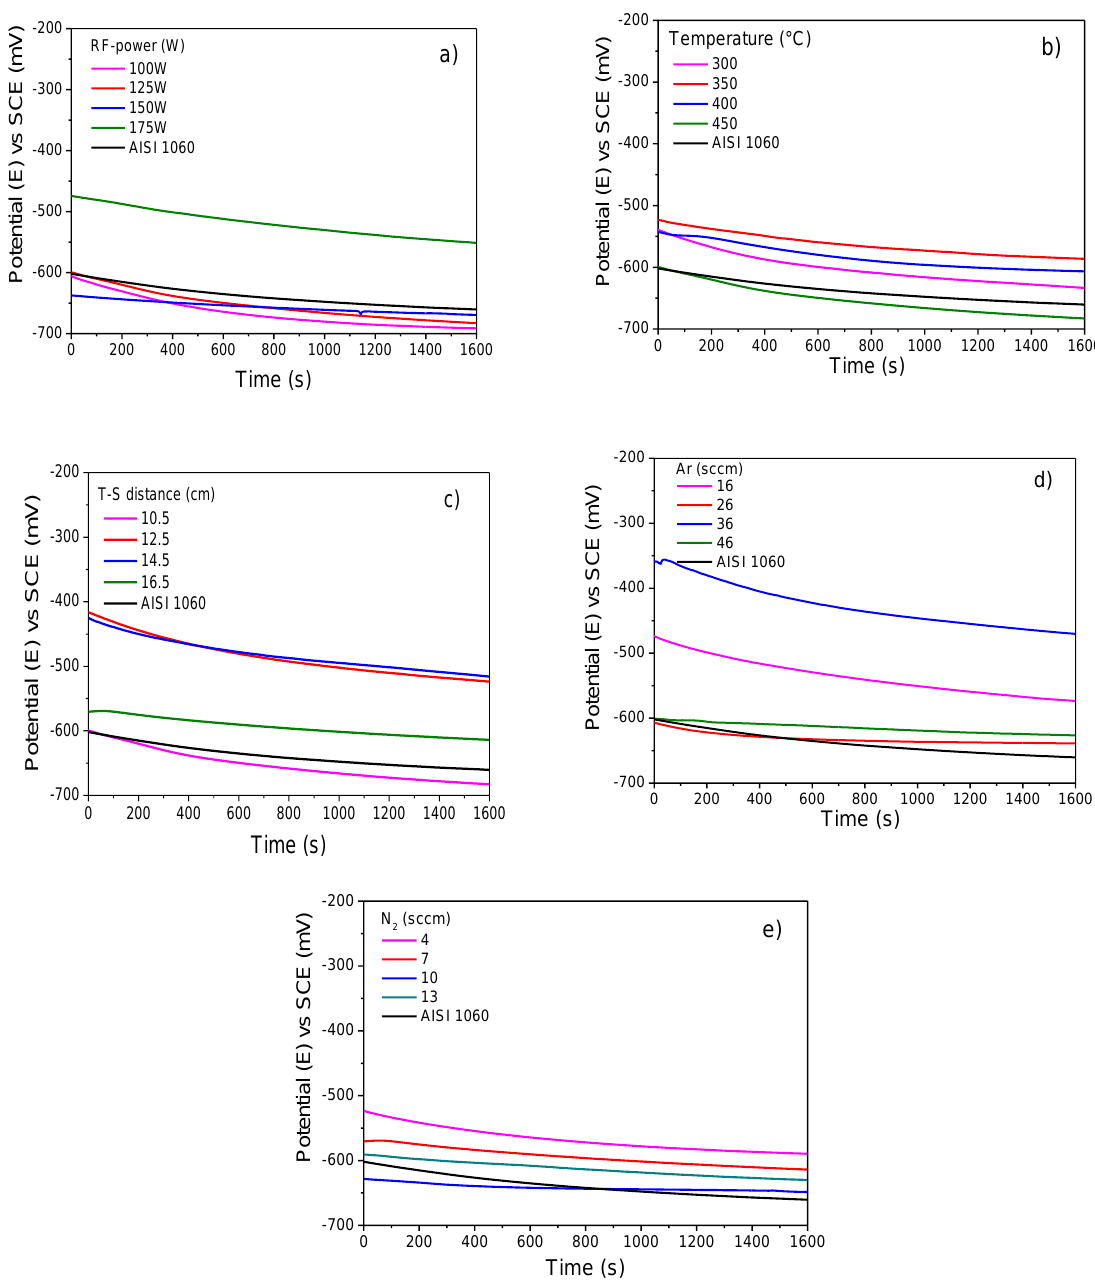
Figure 3. Open circuit potential of Ti/TiN films in neutral 3.5 wt% NaCl solution at room conditions varying the following sputtering parameters: ( a ) RF-power, ( b ) temperature on the substrate, ( c ) target – substrate distance ( d ) argon flow mass, and ( e ) nitrogen flow mass.